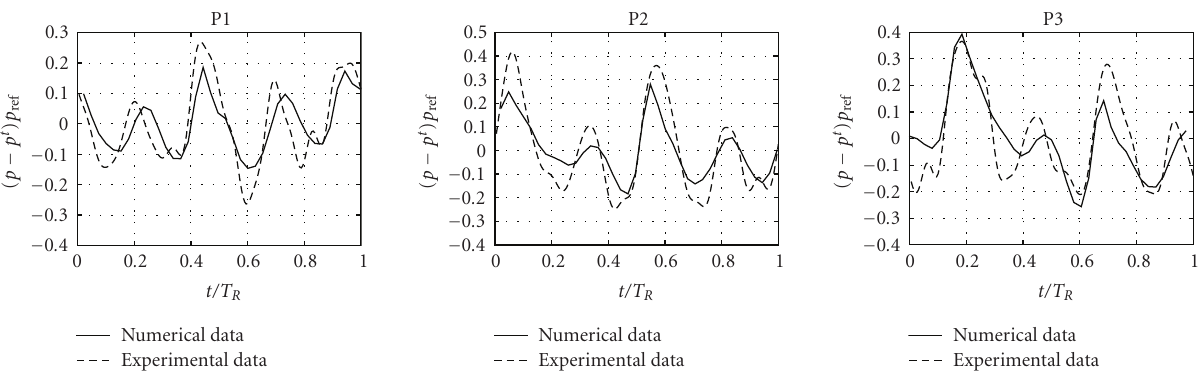
Figure 7: Fluctuations of reduced pressure over a rotor time period at three sensor locations within the di ff user vane passage.